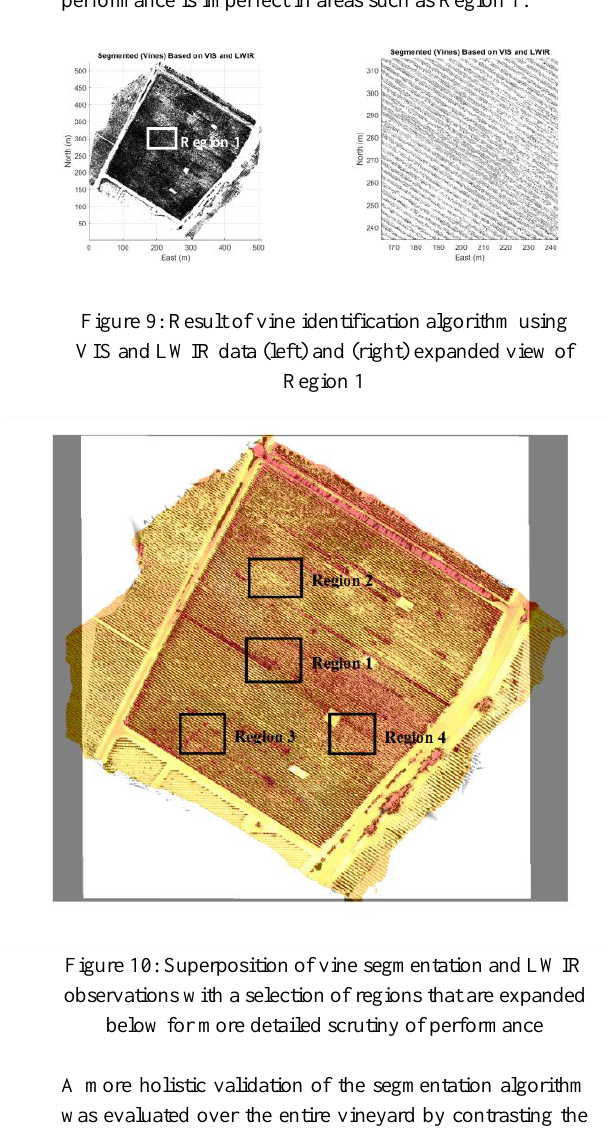
Figure 12 (left) shows an expanded view of Region 2 from Figure 10: an area that appears to be only sparsely populated with vines based on the VIS DPC. Figure 12 (right) shows another expanded view of a section of vineyard where the algorithm has had to deal with complex lighting and foliage